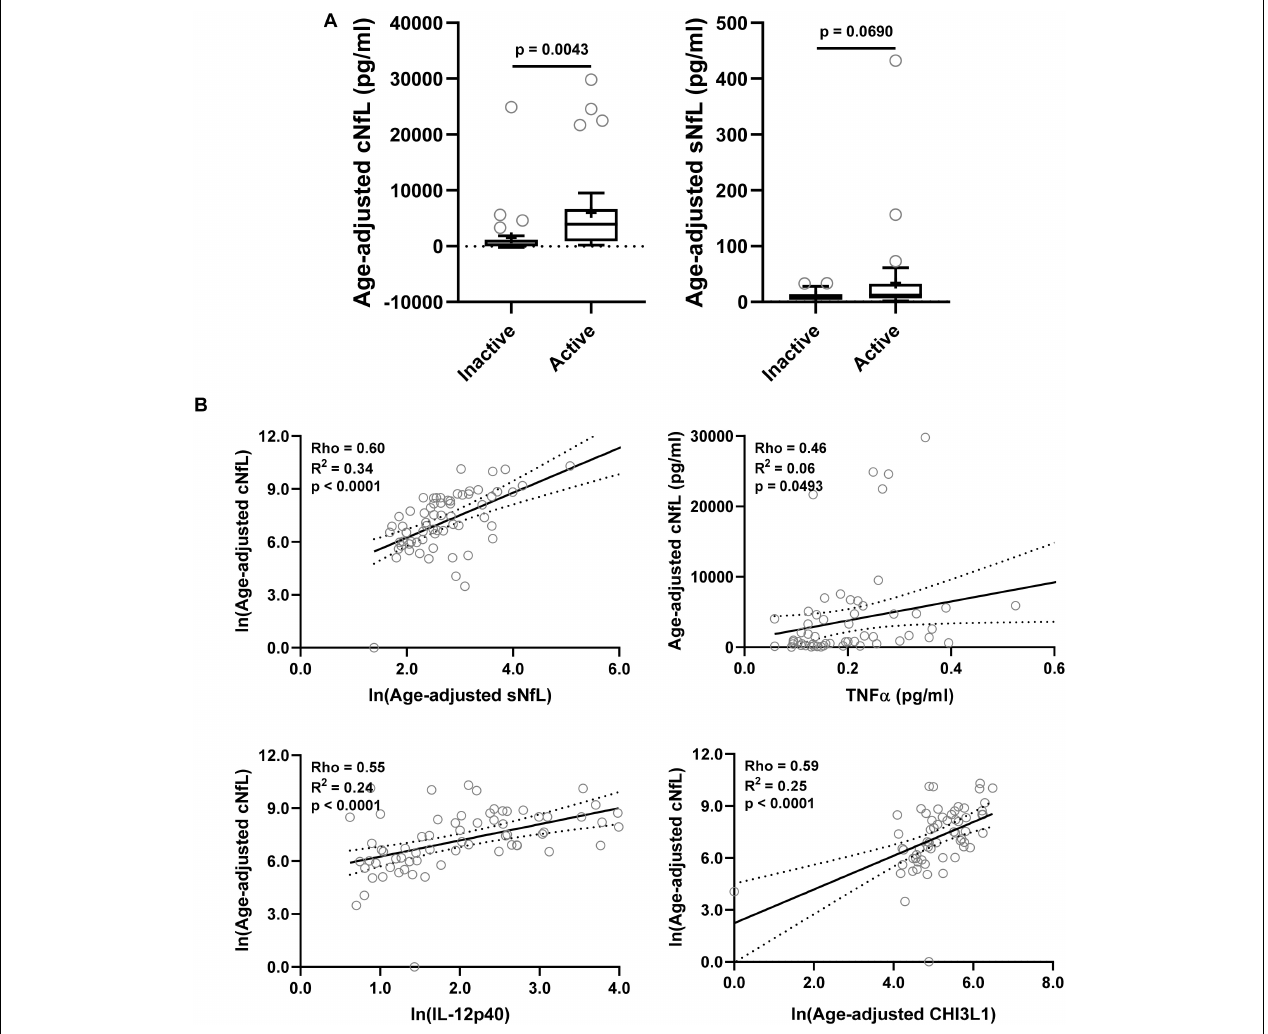
FIGURE 3 | In the training cohort, (A) CSF and serum NfL (cNfL and sNfL) concentrations were compared across MS lesional activity subgroups ( n = 35 each subgroup). The median concentration of HDs is represented with a dotted line, and the mean for respective subgroups is represented with “+” sign. cNfL was significantly elevated in MS patients with active lesional activity ( p < 0.0043; unpaired t -test). However, though sNfL was elevated in active MS patients it did not reach predefined statistical significance ( p = 0.0690). (B) Within MS patients ( n = 70) correlations between cNfL and all other biomarkers were analyzed; Only for statistically significantly ( p < 0.01; Spearman correlation analysis) correlated biomarkers linear regression with cNfL as a dependent variable was analyzed. Solid line represents “line of best fit,” and dotted line represents 95% confidence